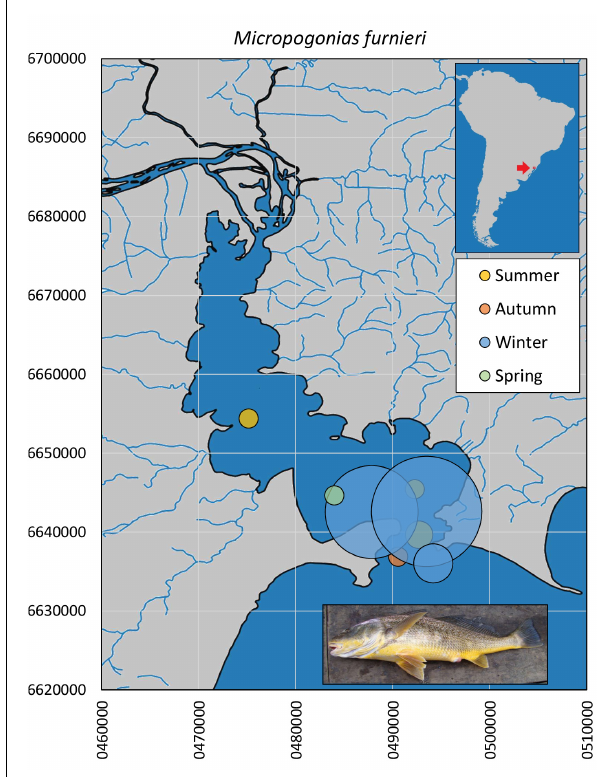
FIGURE 7 | Spatial and seasonal relative abundance of G. genidens in Guaíba Lake, southern Brazil. Bubble area proportional to number of captures per site ( n = 27 individuals). Fish photograph from Timm, C.D. available at Fishbase.com. Vector map background from FEPAM open database (http://www.fepam.rs.gov.br/biblioteca/geo/bases_geo.asp). 22J UTM